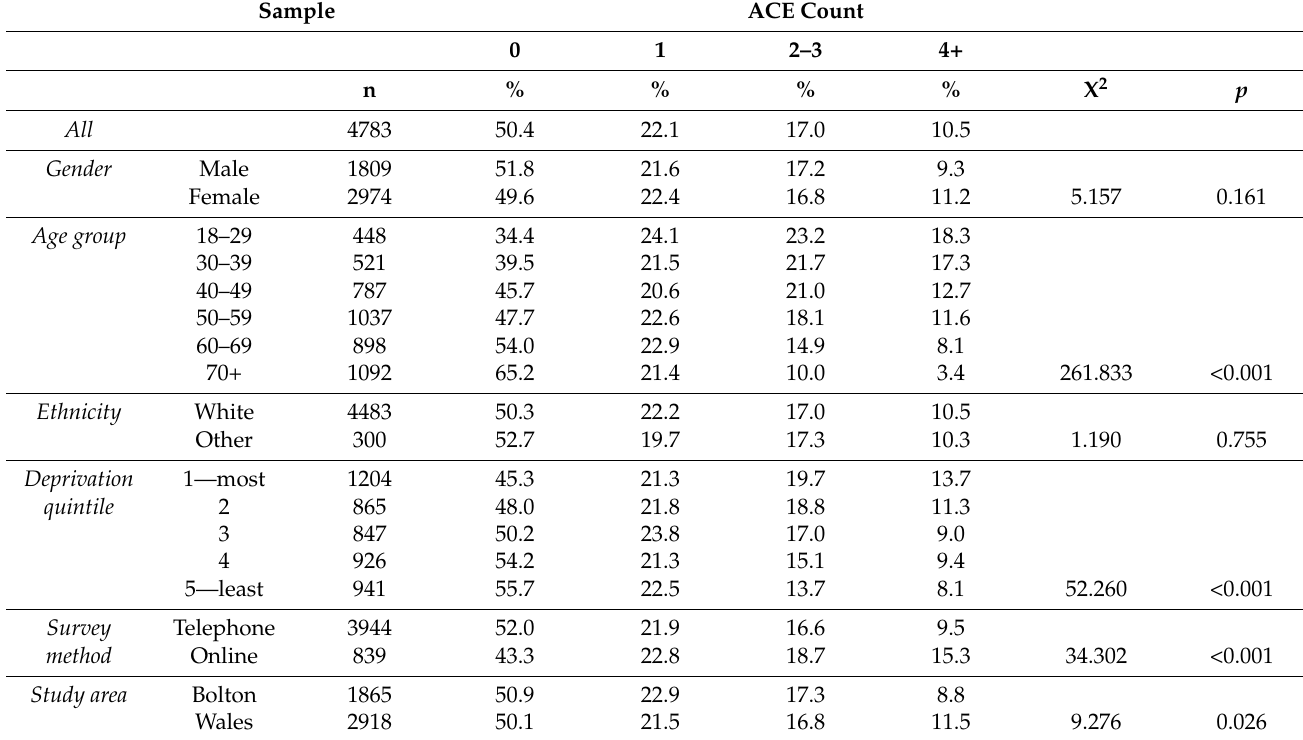
Table 1. Sample demographics and distribution of ACE